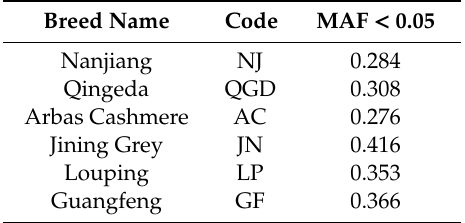
Table 2. Summary of MAF in the six goat populations.